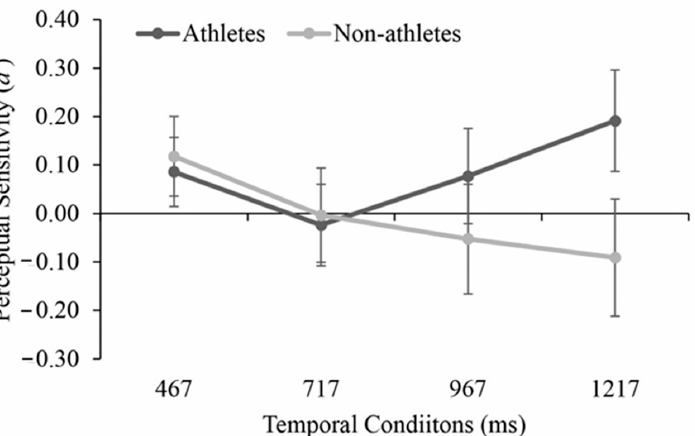
Figure 4. Mean perceptual sensitivity for athletes and non-athletes under four temporal conditions. Bars indicate standard errors.